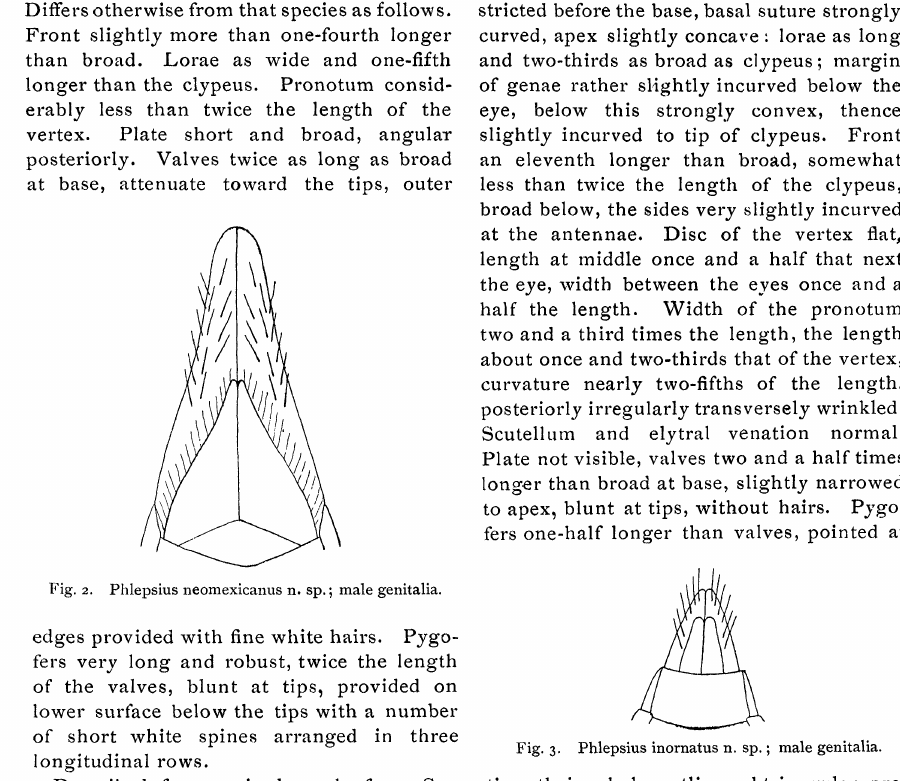
Fig. 3. Phlepsius inornatus sp. male genitalia. tips, their whole outline subtriangular, pro- vided on disc of lower surface with several rather long whitish spines arranged in a single longitudinal row. Color very pale yellowish., deeper on the abdomen. Pronotum with five very indis- tinct longitudinal whitish bands. Elytra translucent, pale milky white, with indistinct smoky clouds on the discs of some of